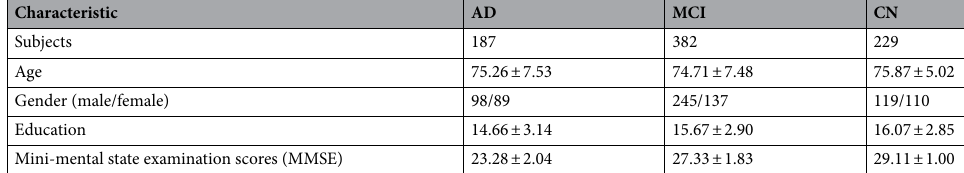
Table 1. Demographic information of the subjects in ADNI-1. The age, education years, and MMSE values are reported as Mean ± Standard deviation (Std).